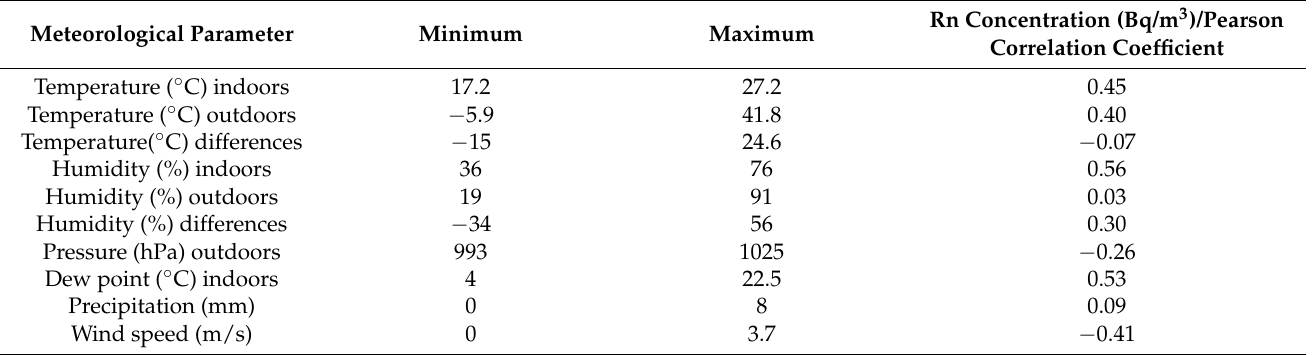
Table 1. Daily minimum and maximum values of meteorological parameters, and Pearson correlation coefficient between indoor radon and meteorological